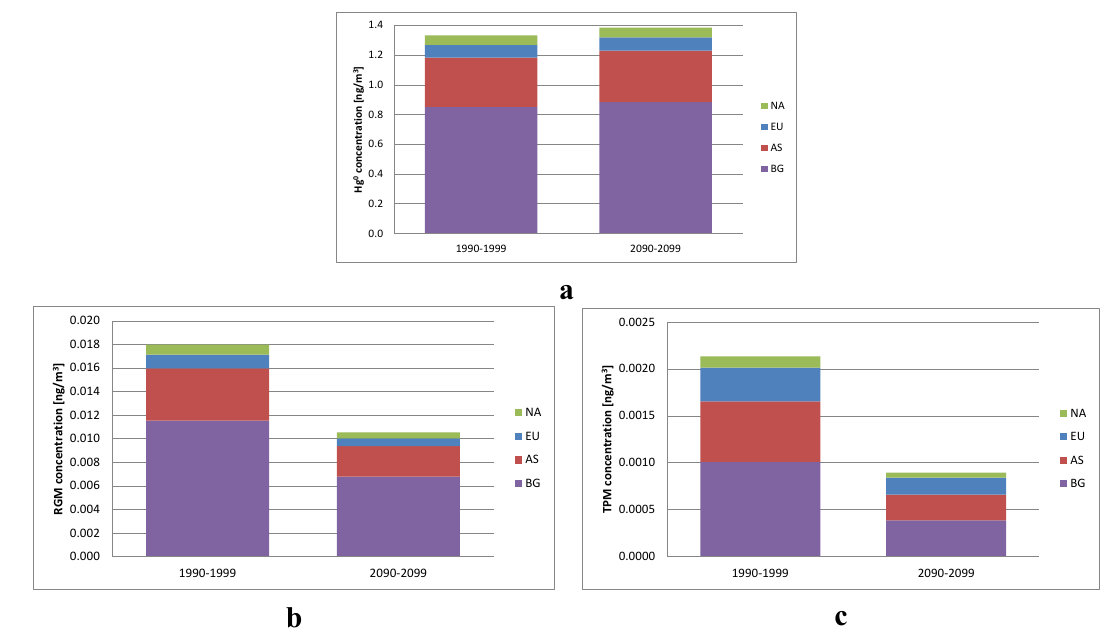
Figure 2. The average Artic air concentrations of Hg 0 ( a ), Reactive Gaseous Mercury (RGM = HgO + HgCl 2 ) ( b ) and Total Particular Mercury (TPM = primary + oxidized particulate Hg) ( c ) for the 1990s and 2090s divided into the contribution from North America (NA), Europe (EU), Asia (AS), and background concentration (BG).